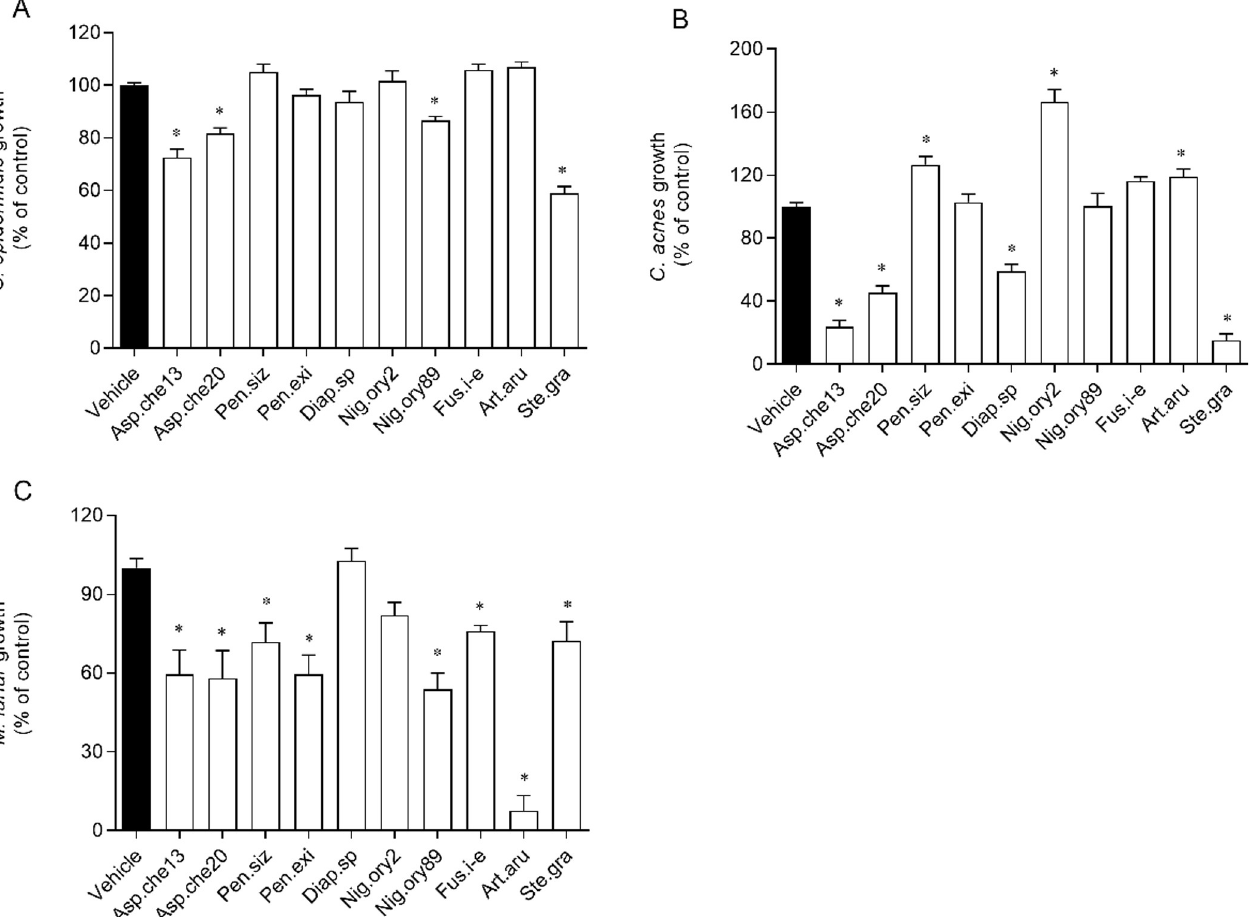
Fig 6. Inhibitory activity of the crude extracts obtained from endophytic fungi associated with Halopteris scoparia against Staphylococcus epidermidis (A), Cutibacterium acnes (B) and Malassezia furfur (C) growth, at 200 μ g/mL. The fungi from which the extracts were obtained are abbreviated as follows: Asp. che13 or 20, isolates 13 or 20 of Aspergillus chevalieri ; Pen.siz, Penicillium sizovae ; Pen.exi, Penicillium sect. Exilicaulis ; Diap.sp, Diaporthe sp.; Nig.ory2 or 89, isolates 2 or 89 of Nigrospora oryzae ; Fus.i-e, Fusarium incarnatum-equiseti complex; Art.aru, Arthrinium arundinis ; Ste.gra, Stemphylium gracilariae . The values correspond to mean ± SEM. � marks significant differences (One-way ANOVA, Dunnett’s test; p < 0.05) when compared with the vehicle.